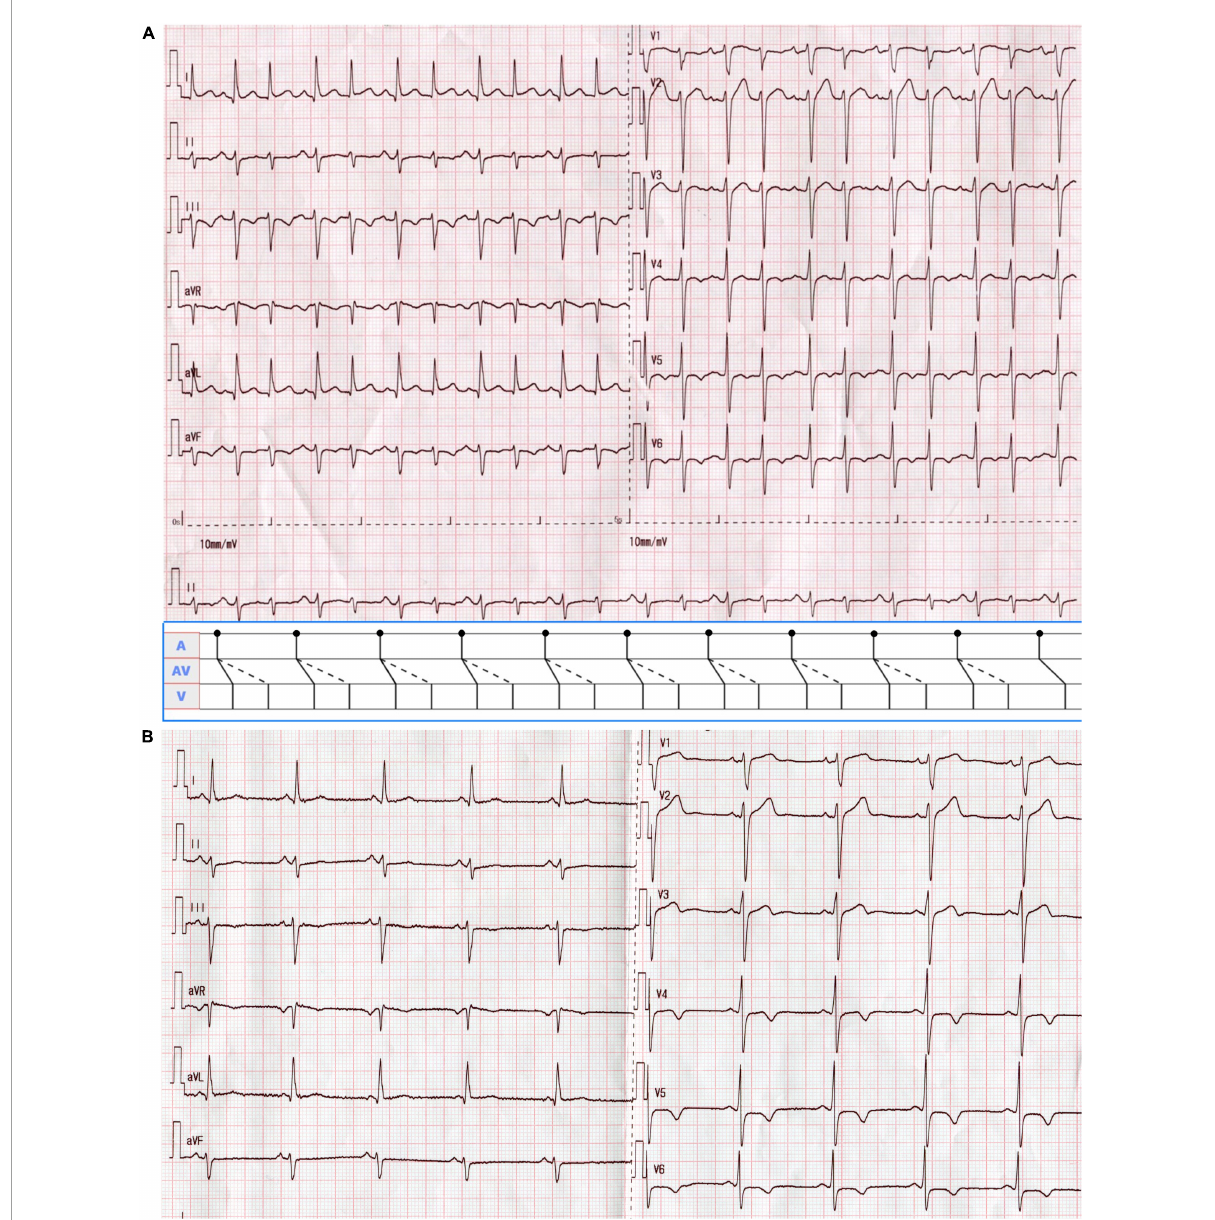
FIGURE2 (A) A 12-lead ECG on admission showed supraventricular tachycardia with alternating RR intervals at a rate of 133 beats/min. The P wave was positive in lead II, negative in aVR, and biphasic in V 1 , suggesting a sinus rhythm of 66 beats/min. Each sinus beat was simultaneously conducted through the anterograde fast and slow AV nodal pathways, giving rise to a double ventricular response. QRS alternans were present as the first and second QRS complexes during 1:2 AV conduction were of different amplitudes. As shown in the ladder diagram, dots indicate the beginnings of the P waves. Solid oblique and dashed lines in the AV portion of the diagram denote conduction over the fast and slow pathways, respectively. (B) The surface ECG returned to normal after radiofrequency ablation.